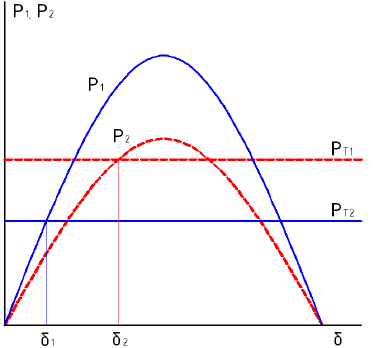
Figure 4. Power-angle curves for salient pole synchronous machines.